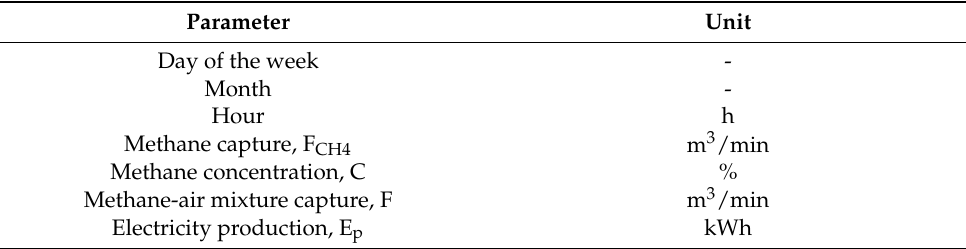
Table 2. Identified variables and